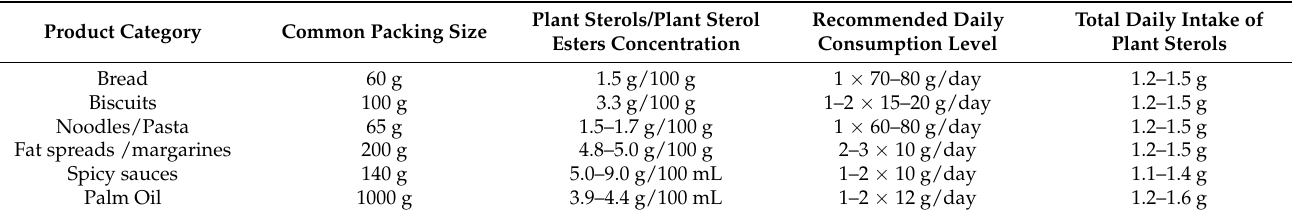
Table 6. Examples of food products to be enriched with plant sterols or plant sterol esters, target concentrations of plant sterols, and recommended consumption